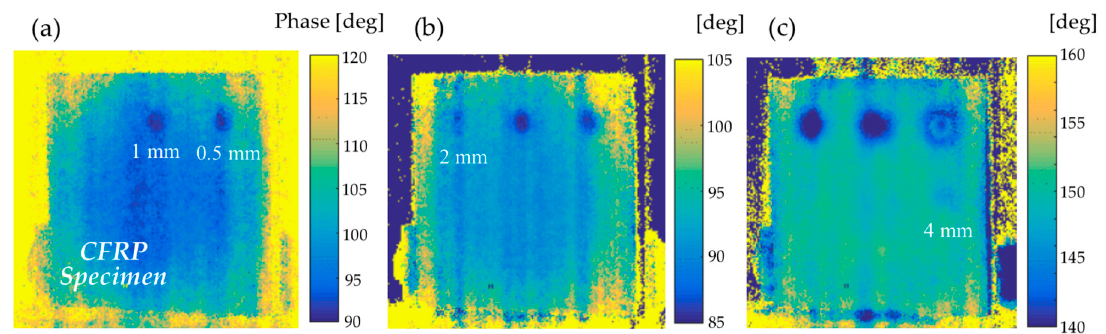
Figure 1. Phase images obtained from temperature data for ( a ) 8 s, ( b ) 14 s, and ( c ) 34 s. Artificial defects are detected as local negative-phase regions; the numerals in the figures show the defect